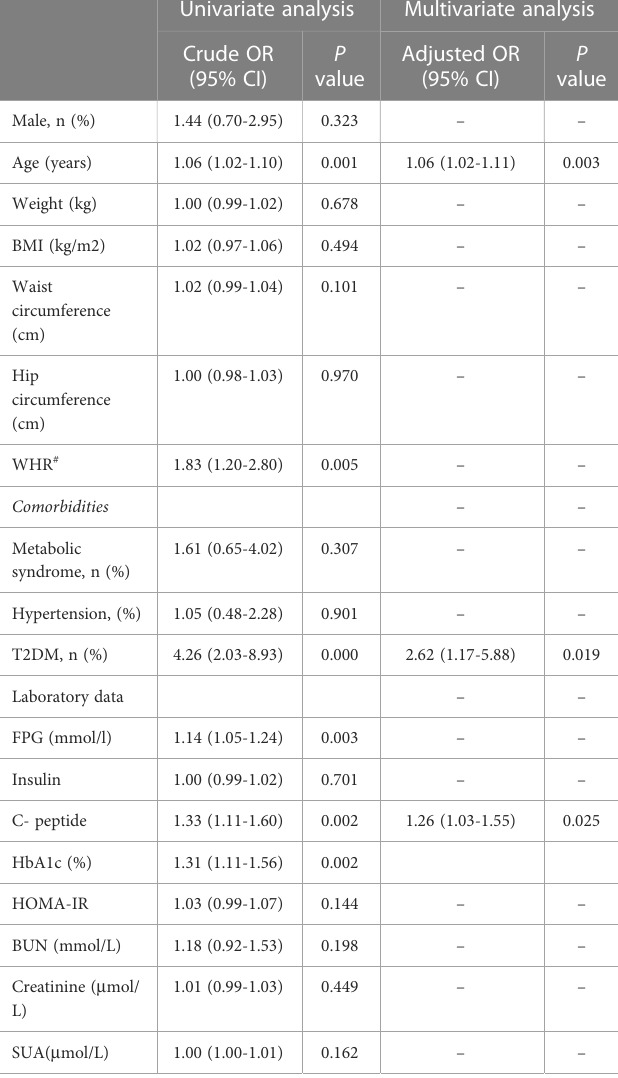
TABLE 3 Univariate and multivariate logistic regression analyses were used to identify independent factors associated with signi fi cant fi brosis. Univariate analysis Multivariate analysis